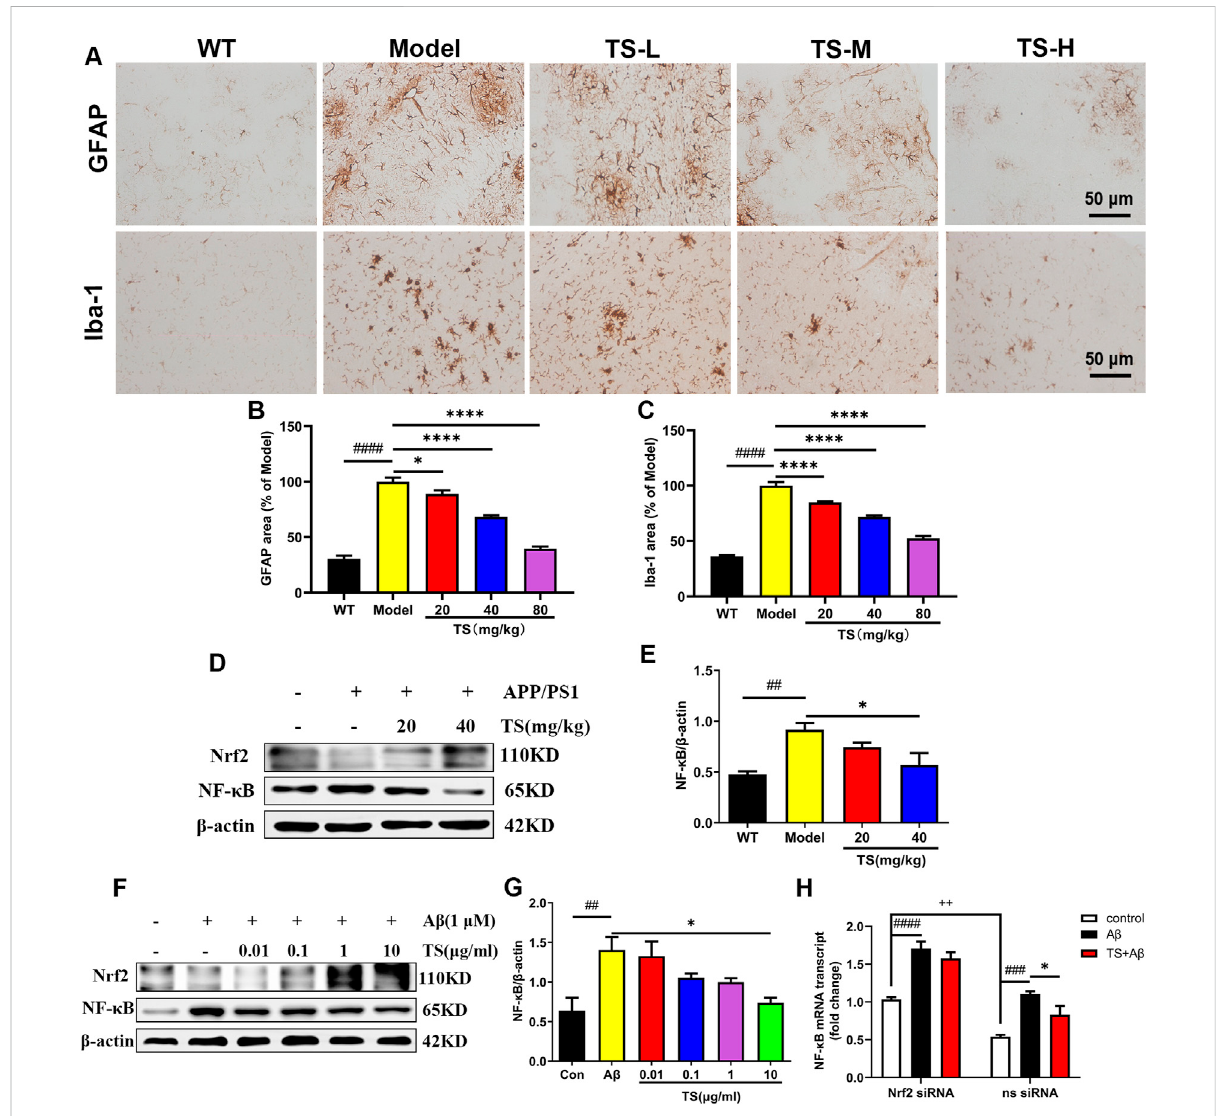
FIGURE 9 TS treatment reduced astrocytes and microglia activation inAPP/PS1 mice. (A) The effects of TS on the activation of astrocytes and microglia in the brain of APP/PS1 mice were investigated by immunohistochemical staining. (B) Quantitative analysis of the percentage of GFAP positive area in thebrainofAPP/PS1 mice( #### p < 0.0001,* p =0.0312,**** p < 0.0001). (C) Quantitativeanalysisofthepercentage ofIba-1positive areainthebrain of APP/PS1 mice ( #### p < 0.0001, **** p < 0.0001). (D) The effects of TS on expressions of Nrf2 and NF- κ B proteinsin thebrain of APP/PS1 mice were detected by Western blot. (E) Quantitative analysis of the relative expression level of NF- κ B protein in each group ( ## p = 0.0068, * p = 0.0243). (F) TheeffectsofTSonexpressionsofNrf2andNF- κ BproteinsintheA β -inducedPC12cellsweredetectedbyWesternblot. (G) Quantitativeanalysis of the relative expression level of NF- κ B protein in each group ( ## p = 0.0048, * p = 0.0126). (H) The effect of TS on the transcription level of NF- κ B in Nrf2 − / − PC12 cells was detected by qPCR. ( ### p = 0.0003, #### p < 0.0001, * p = 0.0382, ++ p = 0.0013). # Compared with WT group; *Compared with model group; + Compared with ns siRNA group. Data are presented as mean ± SEM ( n =